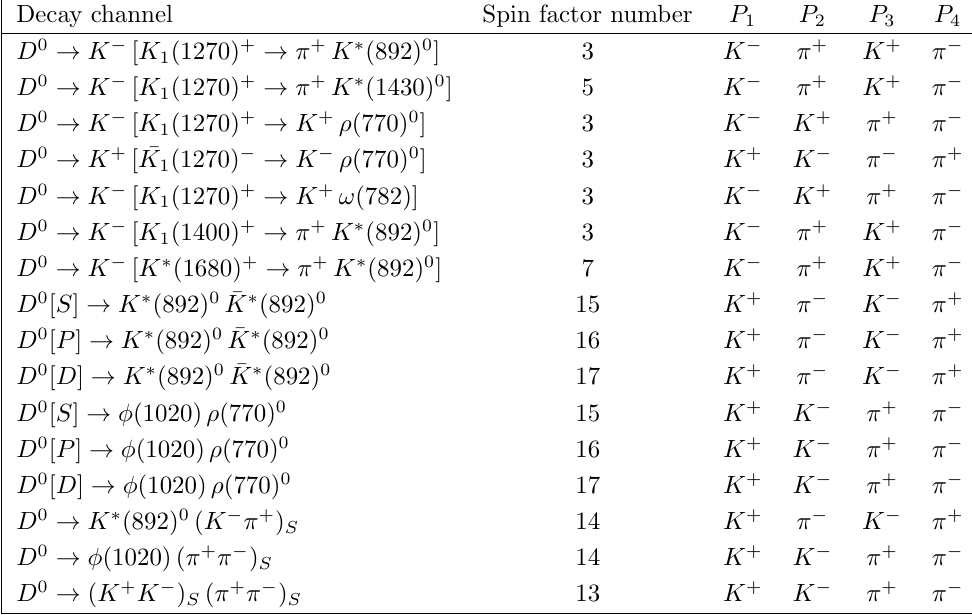
Table 15 . Spin factors used for the decay chains included in the D 0 ! K + K (cid:0) (cid:25) + (cid:25) (cid:0) LASSO model, including the particle numbering scheme. The second column refers to the spin factors as numbered in table 13, and the particles P 1 , P 2 , P 3 , and P 4 refer to those de(cid:12)ned in table 13.